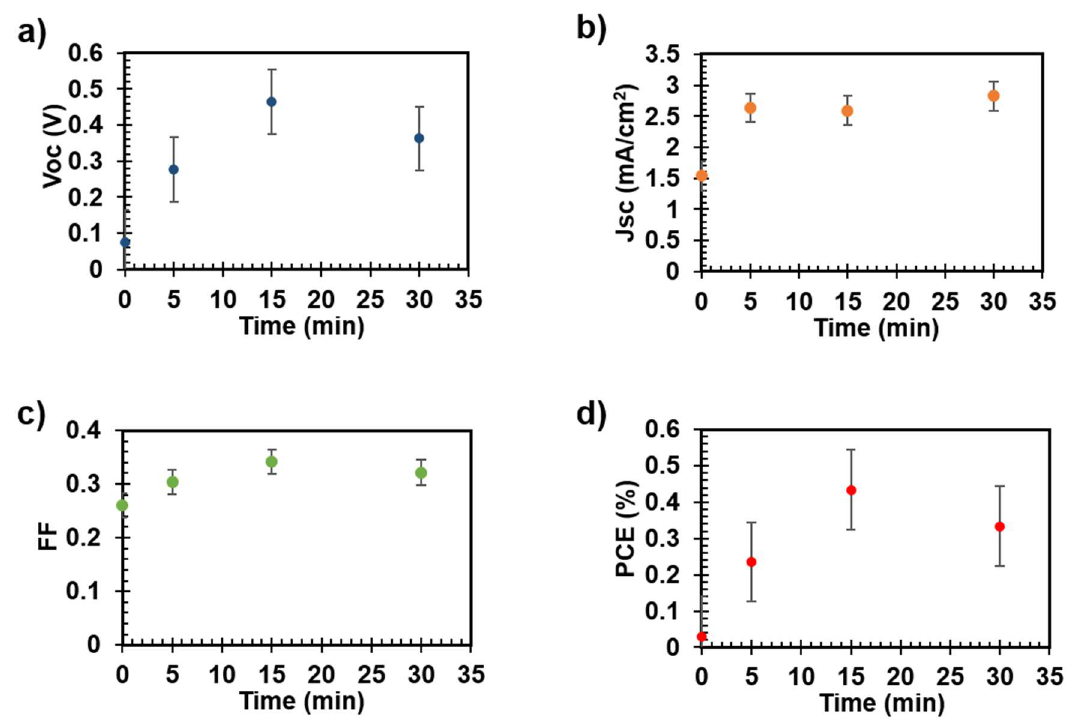
Figure 5. (a) Open-circuit voltage ( V oc), (b) short circuit current ( J sc), (c) fill factor (FF), (d) power conversion efficiency (PCE) vs. annealing time at 150 °C. All devices underwent substrate heating at 150 °C during the evaporation of (345F) 2 -SiPc on PCDTBT/(345F) 2 -SiPc (85 nm).